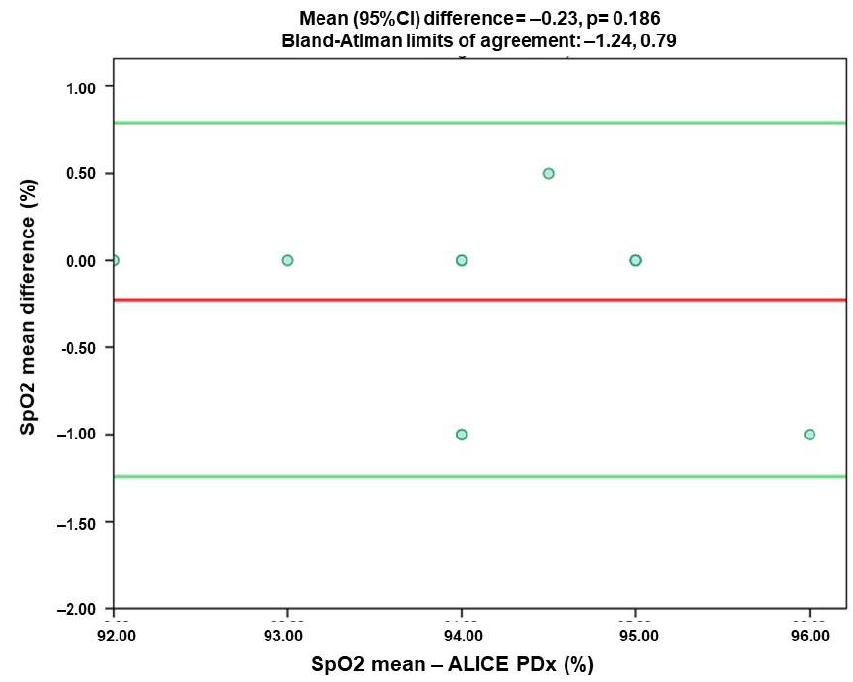
Figure 6. Bland-Altman plots. Distinction between the SpO2 mean-Alice PDx plotted against the two devices’ mean SpO2 difference ( n = 11). The red line presents the mean difference, while the green ones reveal the limits of agreement.